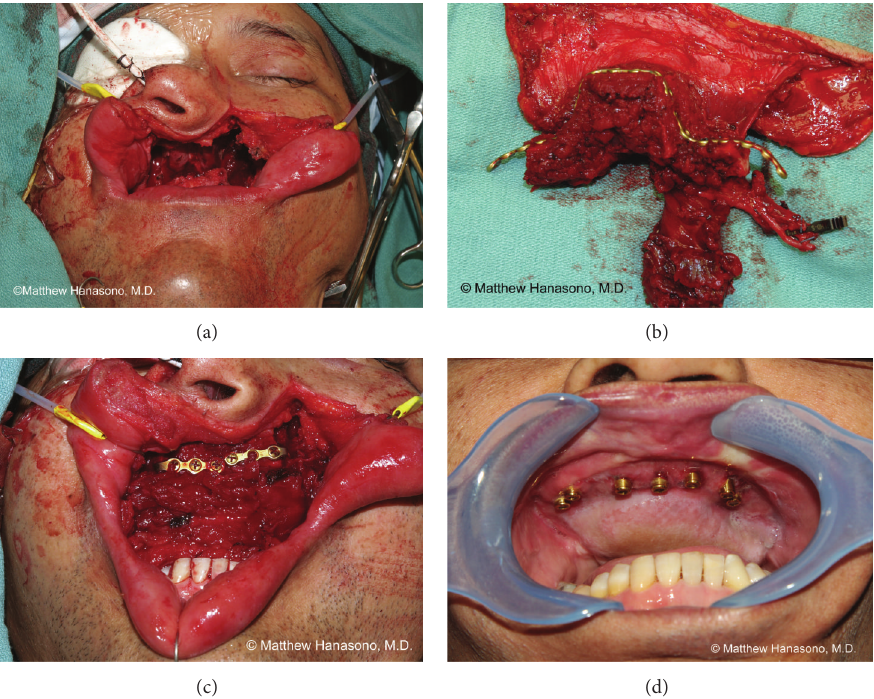
Figure 2: Anterior bilateral palatomaxillary defect following tumor removal (a). A fibula osteocutaneous free flap is osteotomized then rigidly fixated to resemble the Greek letter “omega” in the transverse plane (b). Flap inset (c). Postoperative appearance (d). The skin paddle is used to close the palatal defect, while the bone restores mid-facial height, width, and projection. Osseointegrated implants have been placed.